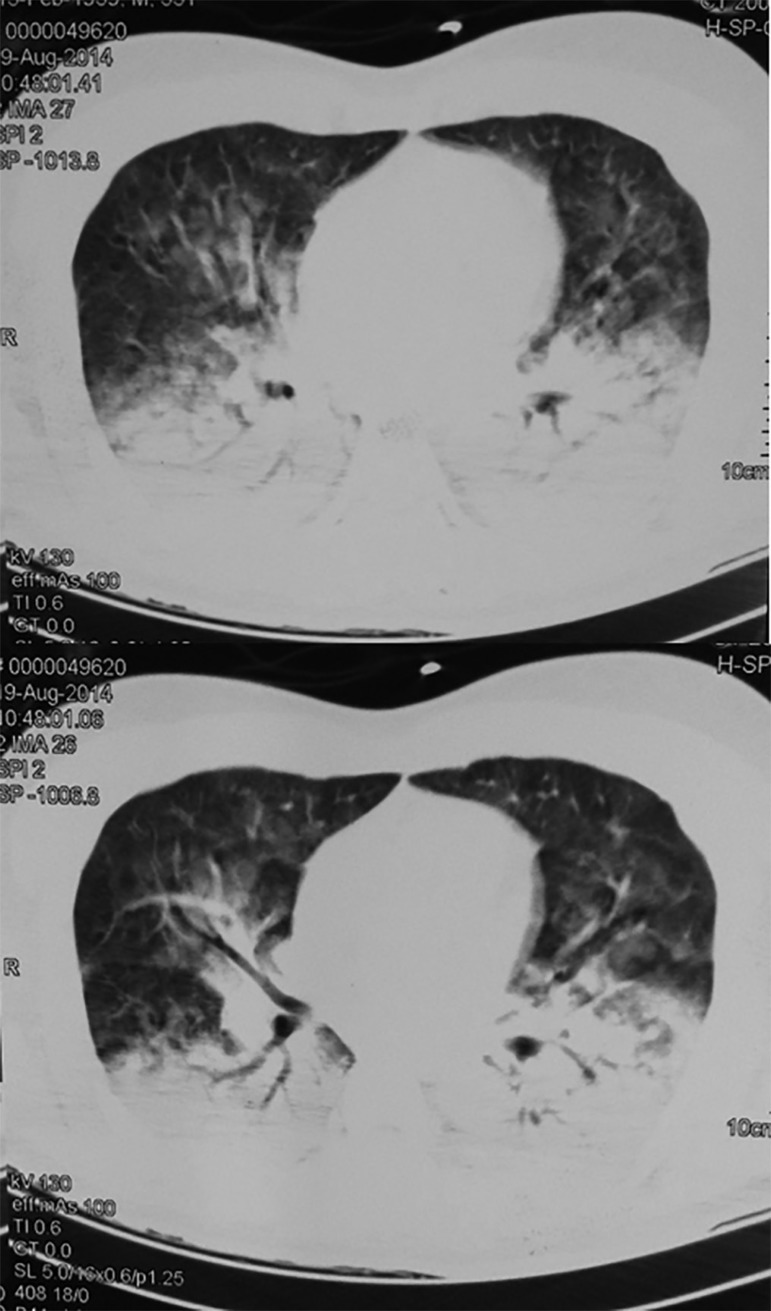
Initial chest computed tomography.